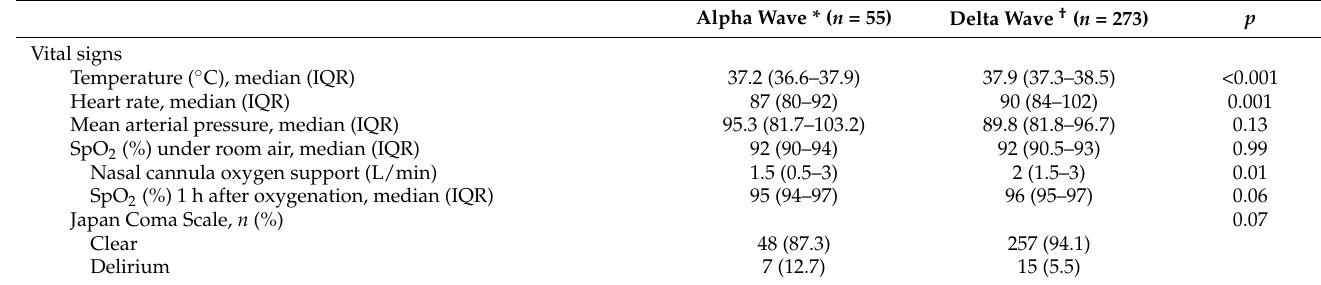
Table 2. Patient vital signs and symptoms at the time of the consultation, according to the wave of the